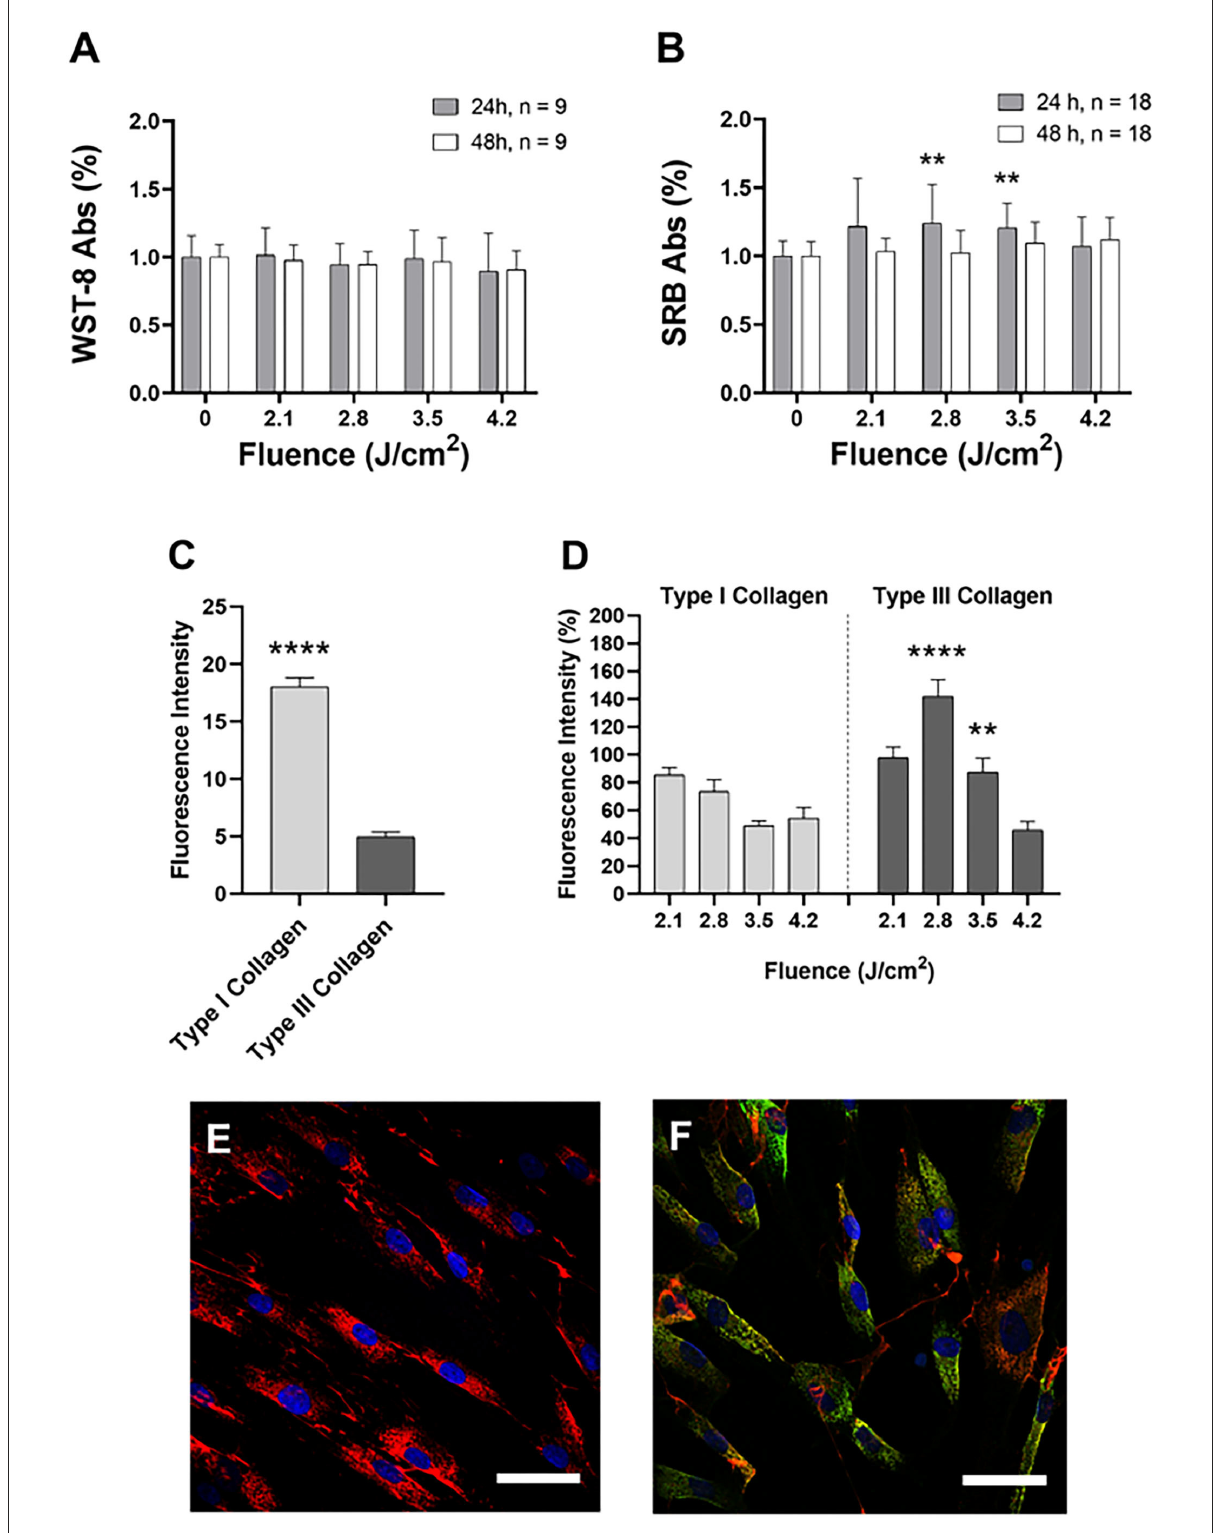
FIGURE1 Cell viability (A) and proliferation (B) after 24h (gray) and 48h (white) after the irradiation. Data are expressed as mean ± SD, n = 9 (A) and n = 18 (B) . Statistical analysis: ** p < 0.01 (vs. 0 fluence). The one-way ANOVA, Kruskal-Wallis test followed by Dunn’s test of multiple